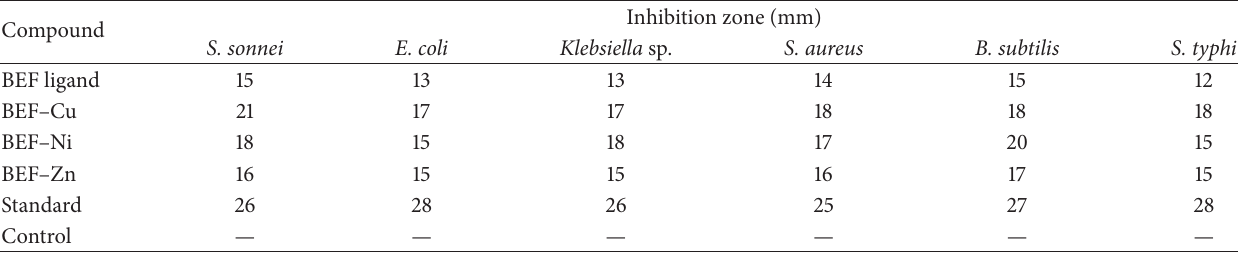
Table 7: Antibacterial activity of BEF ligand and its complexes.